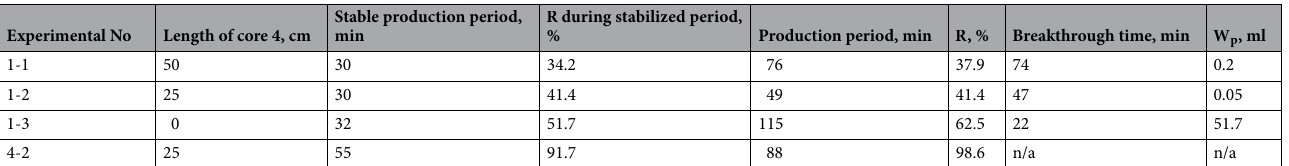
Table 3. Statistics on the production of the Group I and Experiment